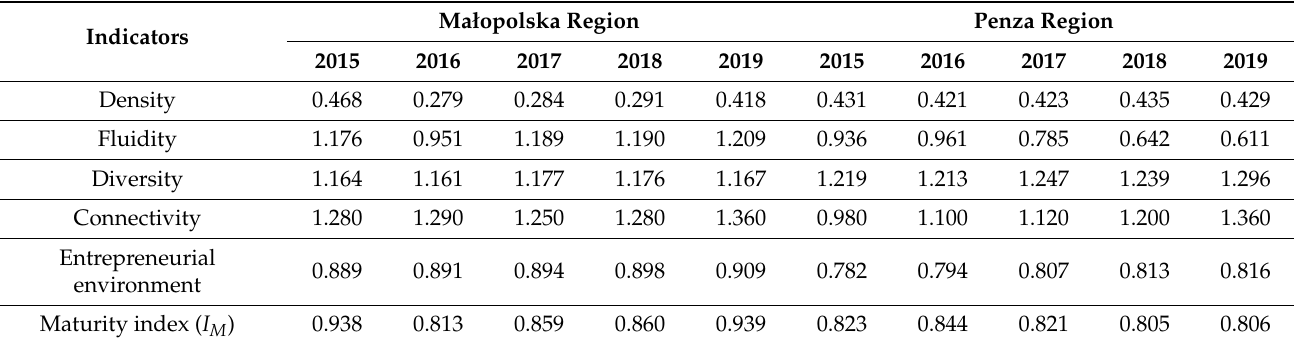
Table 6. Calculating the results of indicators for assessing the maturity of entrepreneurial ecosystems in the Penza and the Małopolska